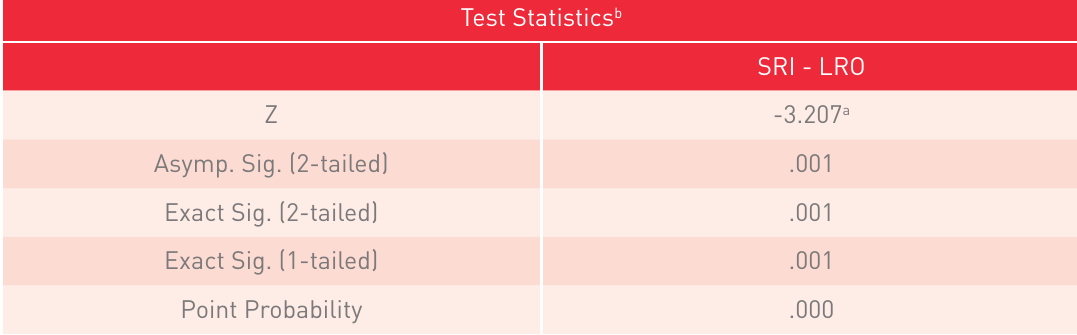
Result of Wilcoxon Signed-Ranks